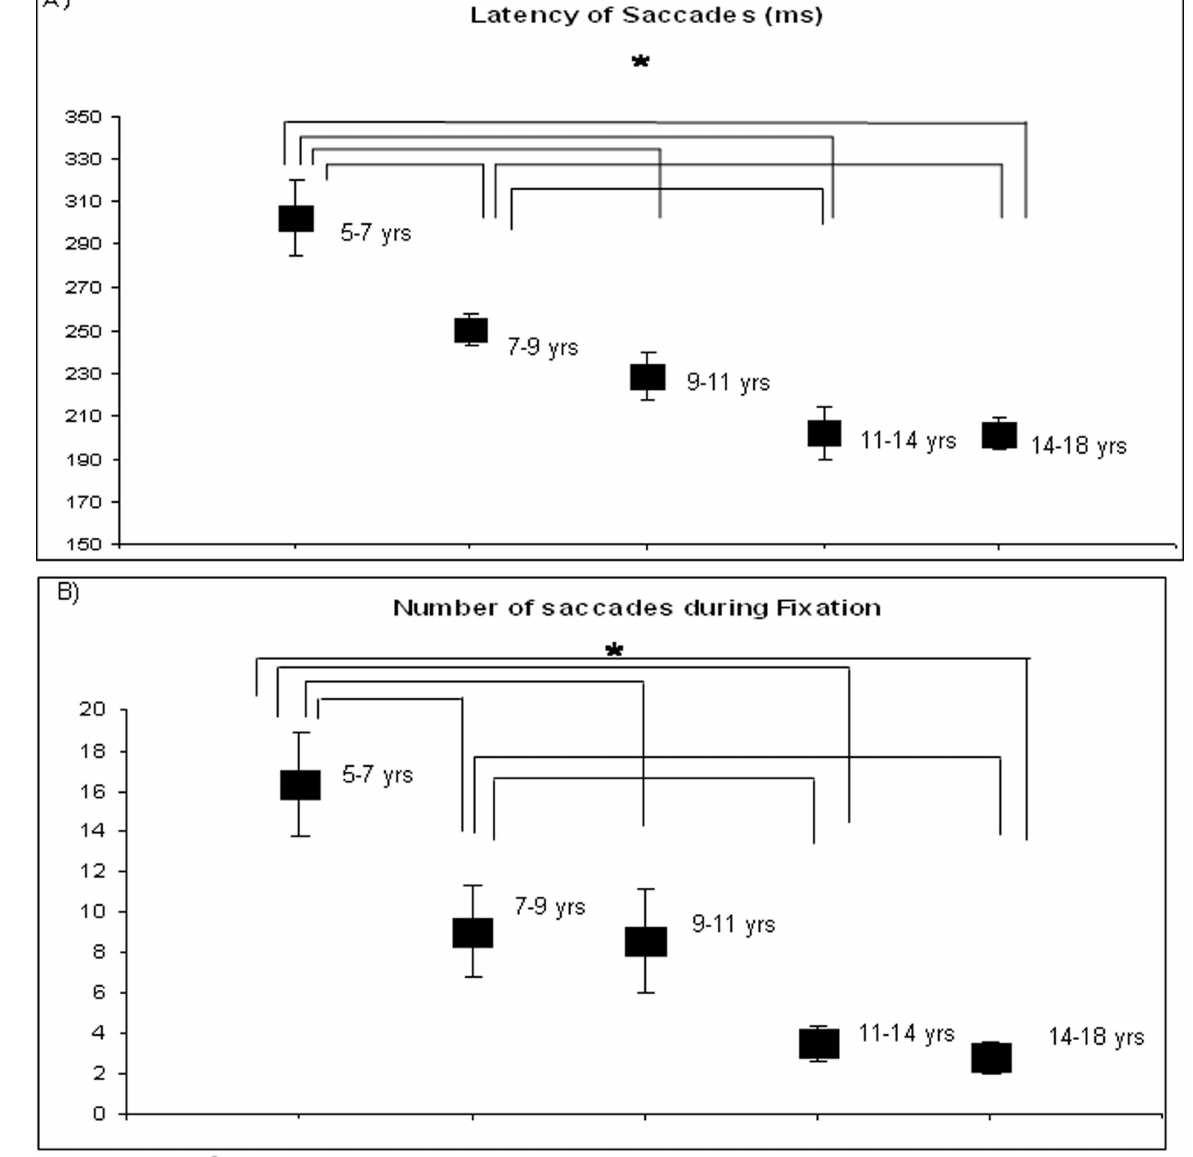
Figure 1. Eye movements executed during postural task for the five groups of subjects. Figure 1A : Mean values of latency of saccades (in milliseconds) during postural task. Vertical bars indicate the standard error. Asterisks indicate that the value is significantly different (p , 0.003). Figure 1B : Mean values of number of saccades during fixation during postural task. Vertical bars indicate the standard error. Asterisks indicate that the value is significantly different (p , 0.02).